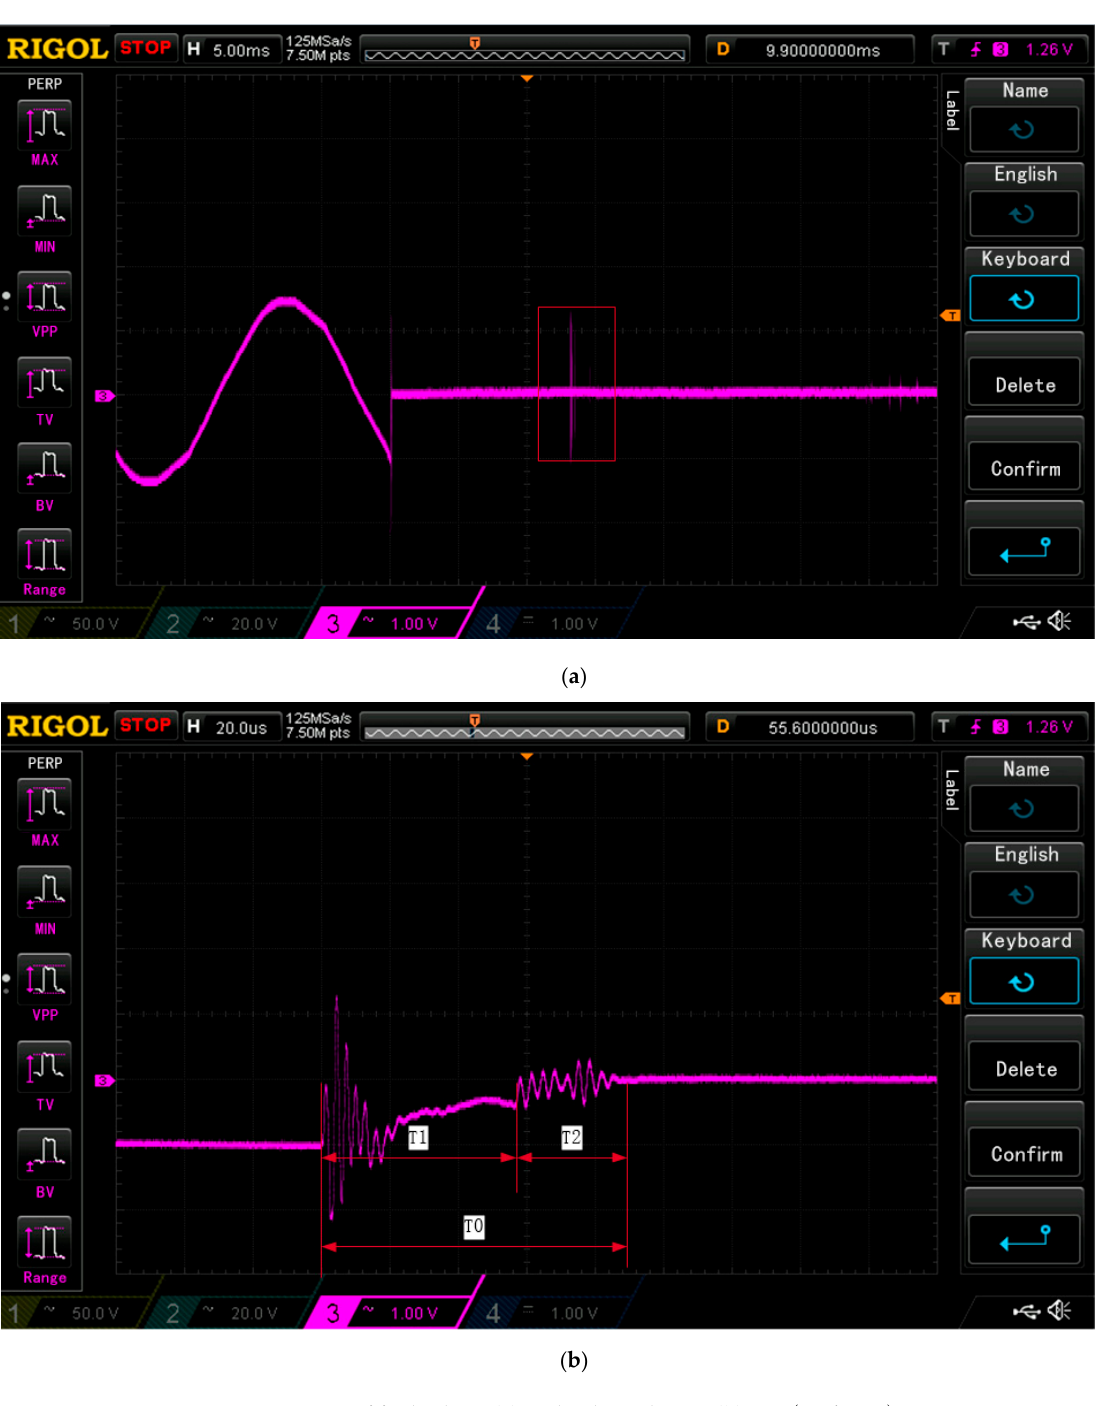
Figure 15. Figure of fault phase ( a ) and enlarged view ( b ) )2,2/3(